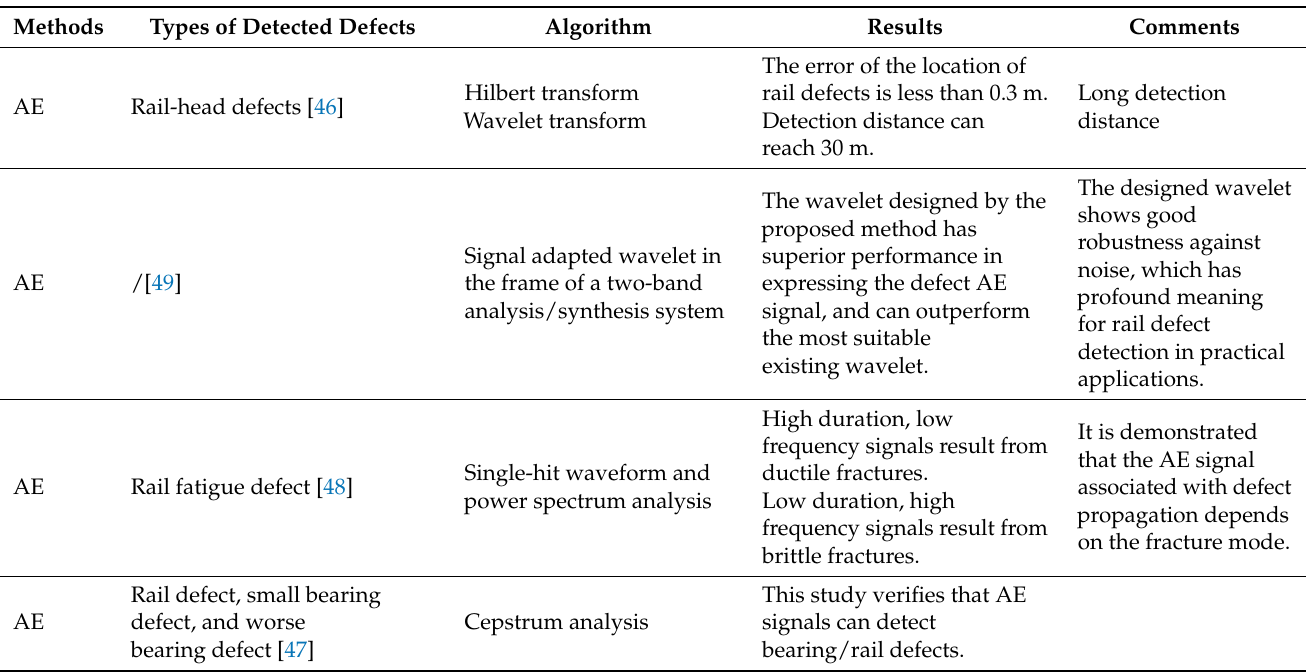
Table 2. Comparison of acoustic emission